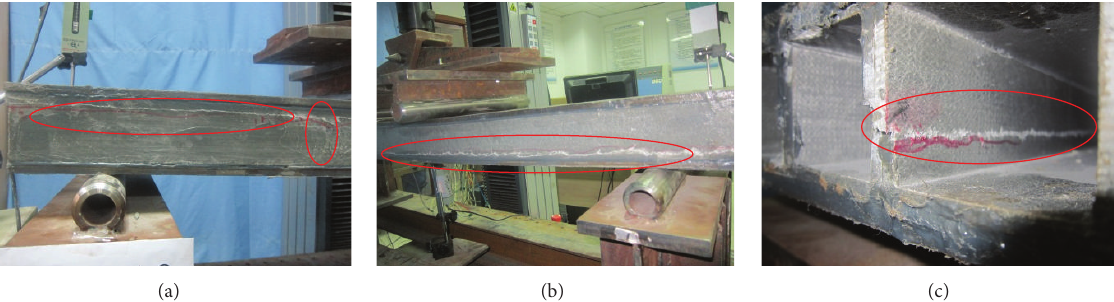
Figure 8: Failure of specimen S( 10 )-GFRP: (a) spreading of cracks, (b) cracks appearing where the web and the lower facesheet intersected, and (c) breaking of specimen rib.